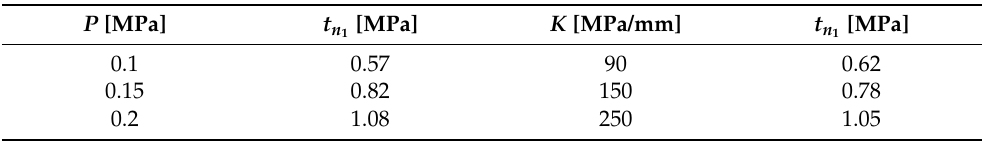
Table 4. Median normal contact traction comparison for different uniform clamping pressures P and Winkler elastic support stiffness K .